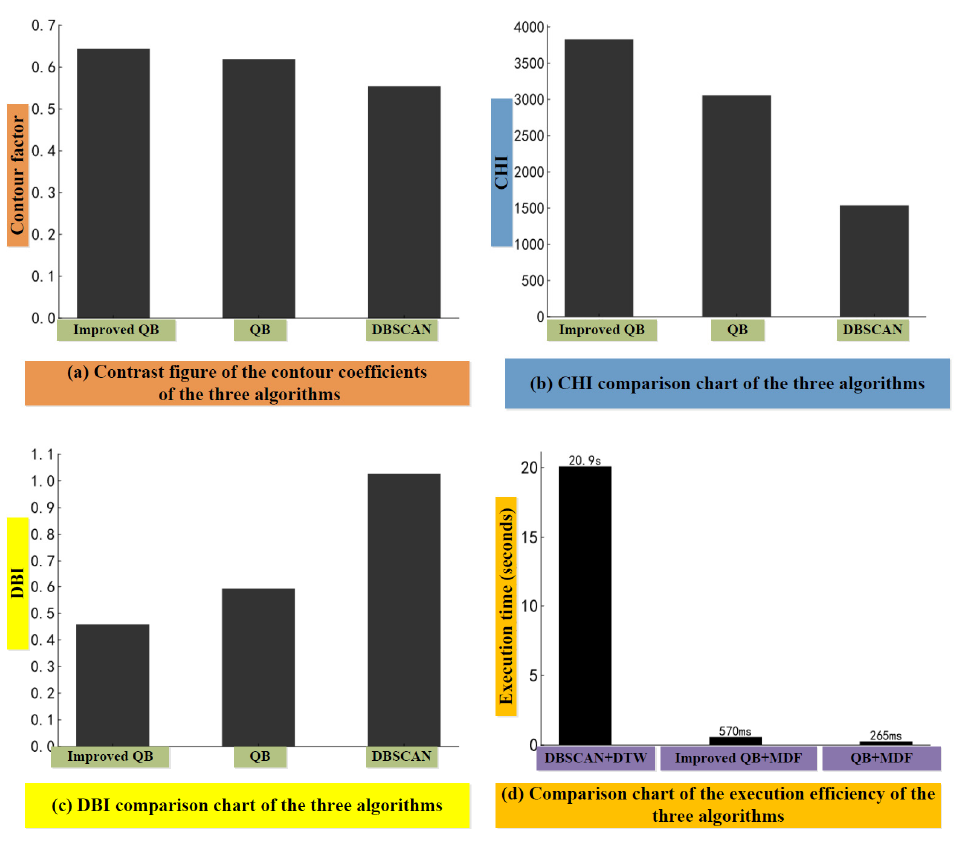
Figure 15. Comparison of the clustering evaluation indicators of the three algorithms.